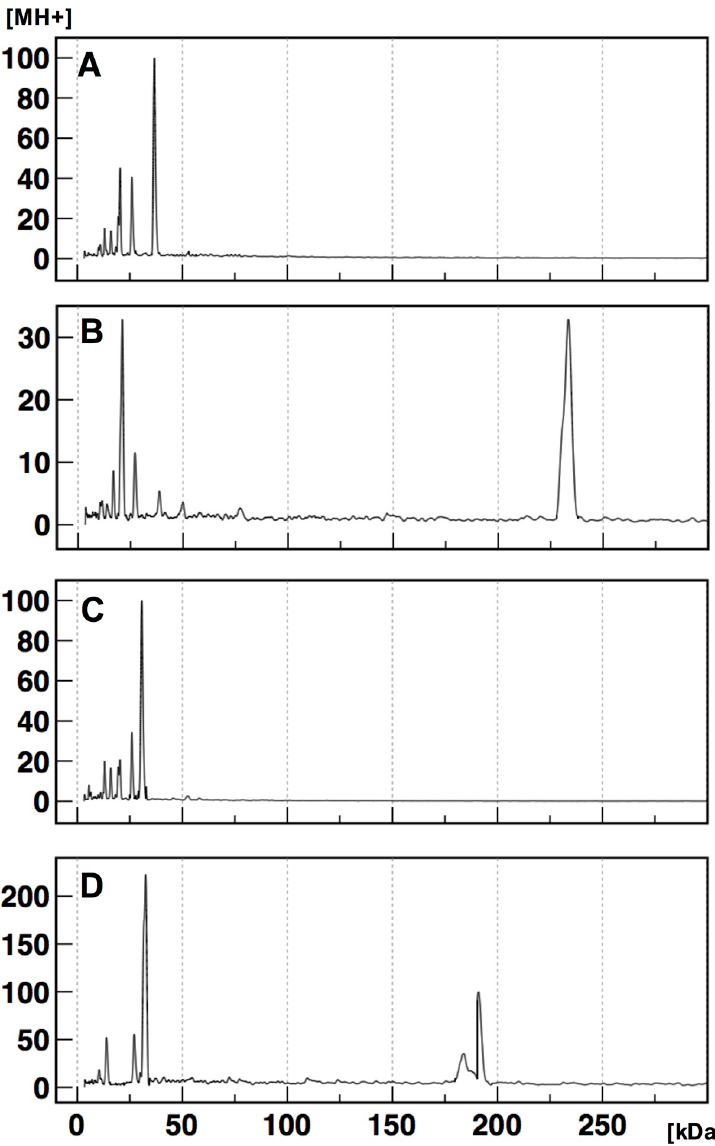
wt . (B) Analysis after treatment with crosslinker of purified RodZ wt . (C) Analysis without crosslinker of the purified N-terminal deletion RodZ 50-337 . (D) Analysis after treatment with crosslinker of the purified N-terminal deletion RodZ 50-337 . The data for 0–300 kDa species are presented here, and those for the entire mass range (0–1500 kDa) are shown in S2 Fig. Graphs show representative examples of serial 10-fold dilution of samples. The average values are stated in the Results